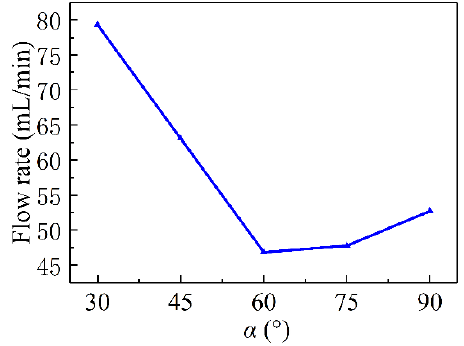
Figure 11. Corresponding maximum flow under different α .